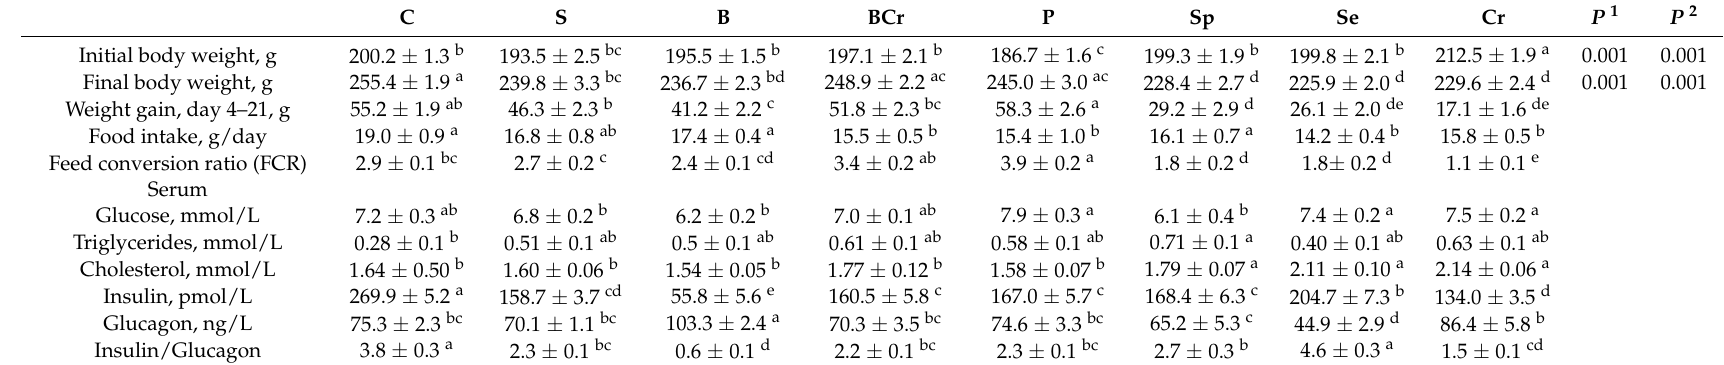
C, casein; S, soy protein; B, black bean protein; P, pea protein; Sp, spirulin protein; Se, sesame protein; Cr, corn protein. The values are mean ± SEM. Means in a row without a common letter differ, p < 0.05. Differences are based on one-way ANOVA. Tukey test was used as post hoc analysis; P 1 , weight; P 2 , weight ×